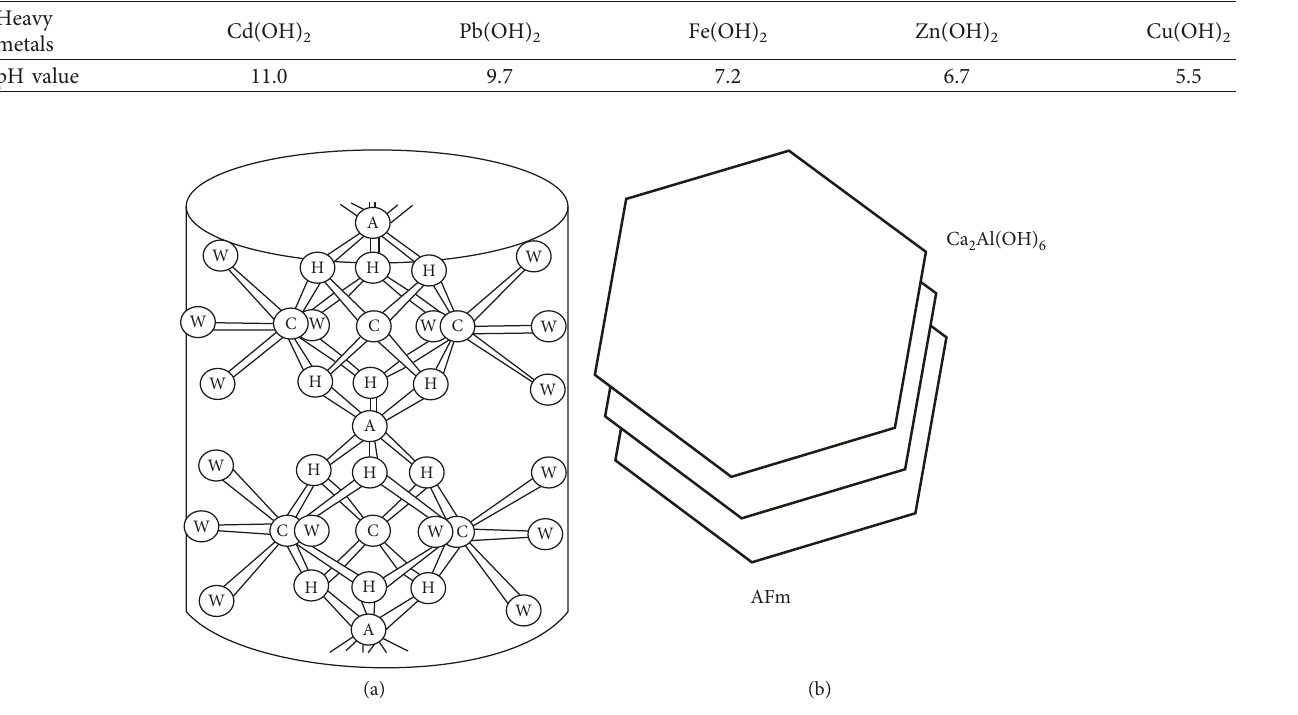
Table 4: Optimum pH value of heavy metal precipitates.